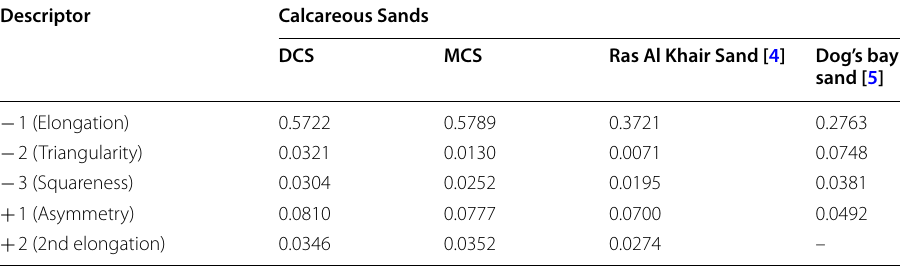
Table 4 Signature Descriptor coefficient for various calcareous sands: Dissa sand, Matmata sand and Ras Al Khair